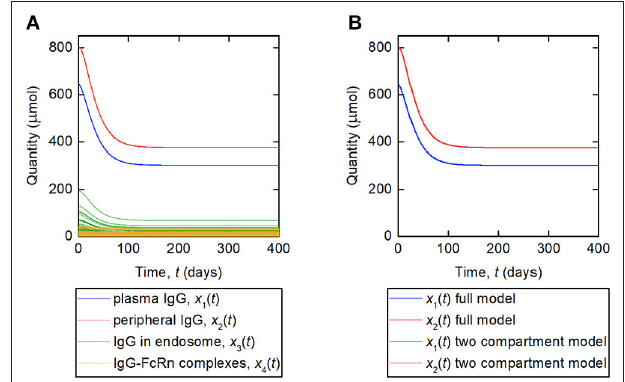
FIGURE 9 | (A) Simulation of responses of plasma IgG [( x 1 ( t )], peripheral IgG [ x 2 ( t )], IgG in endosomes [ x 3 ( t )], and IgG bound to FcRn in endosomes [ x 4 ( t )]. The scenario shown represents a decreasing tumor burden during therapy. Each variable is simulated for 70 unique parameter vectors. (B) Simulation of responses of plasma IgG [ x 1 ( t )], peripheral IgG [ x 2 ( t )], compared for the four-compartment model and the proposed two compartment model. The responses are indistinguishable by inspection for the two